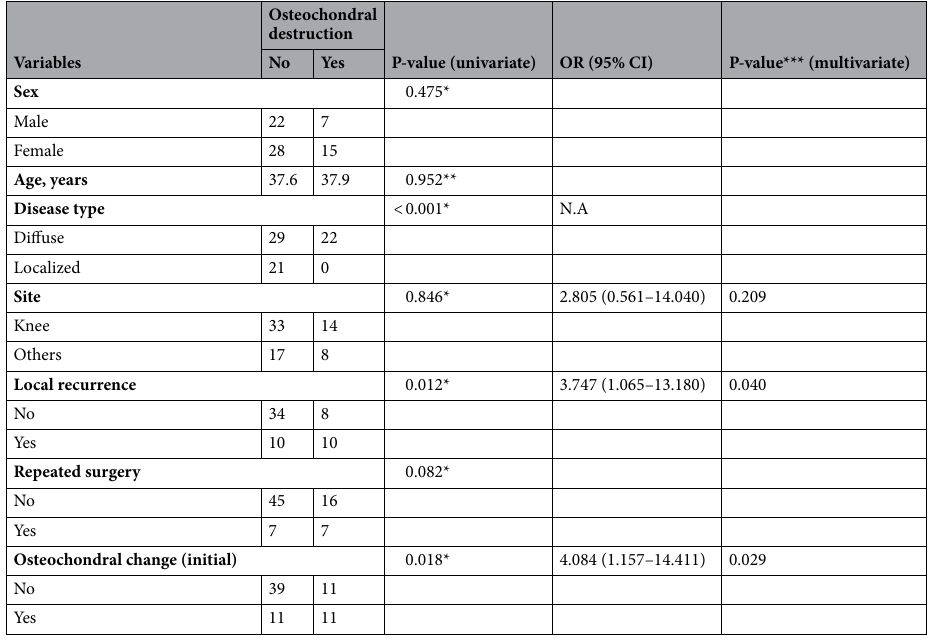
Table 4. Factors influencing osteochondral destruction during follow-up. OR odds ratio, CI confidence interval, N.A. not available. *Fisher’s exact test and Pearson chi-square test. **Mann–Whitney U test. ***Logistic regression